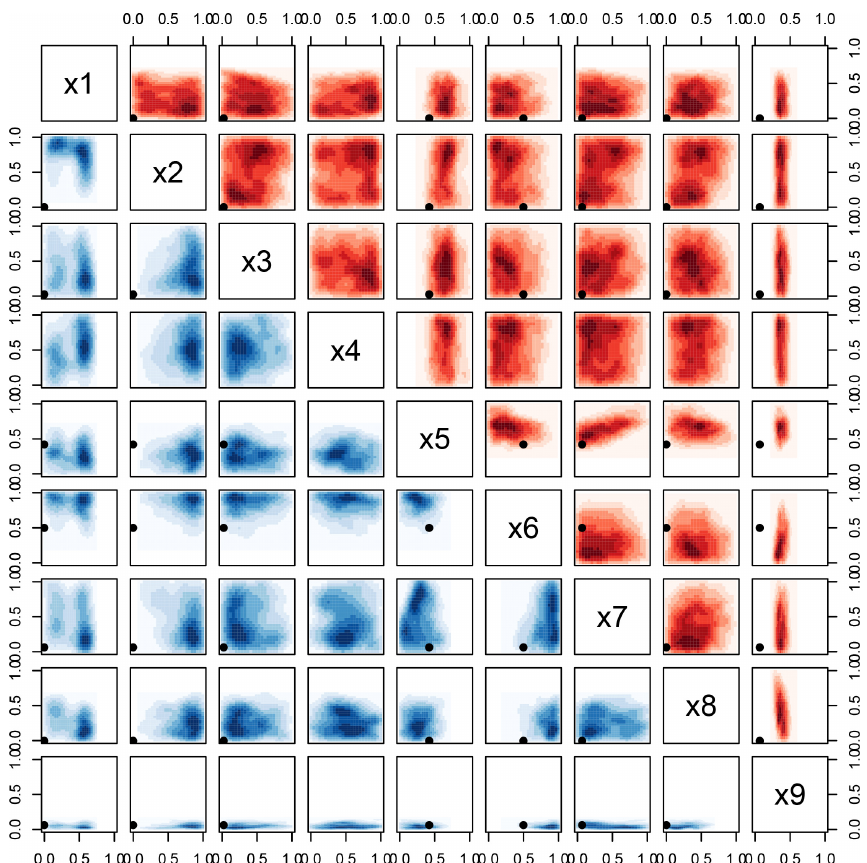
Figure 6. As Fig. 5, except that panels with blue shading (lower triangle) are for the subset of cases with low values of Cess climate sensitivity ( λ < 0 . 418KW − 1 m 2 ), and panels with red shading (upper triangle) are for the subset of cases with high values of λ ( λ > 0 . 538KW − 1 m 2 ). The default values for each parameter in CAM4 are indicated by black dots in each panel (except for x 4 , which has no